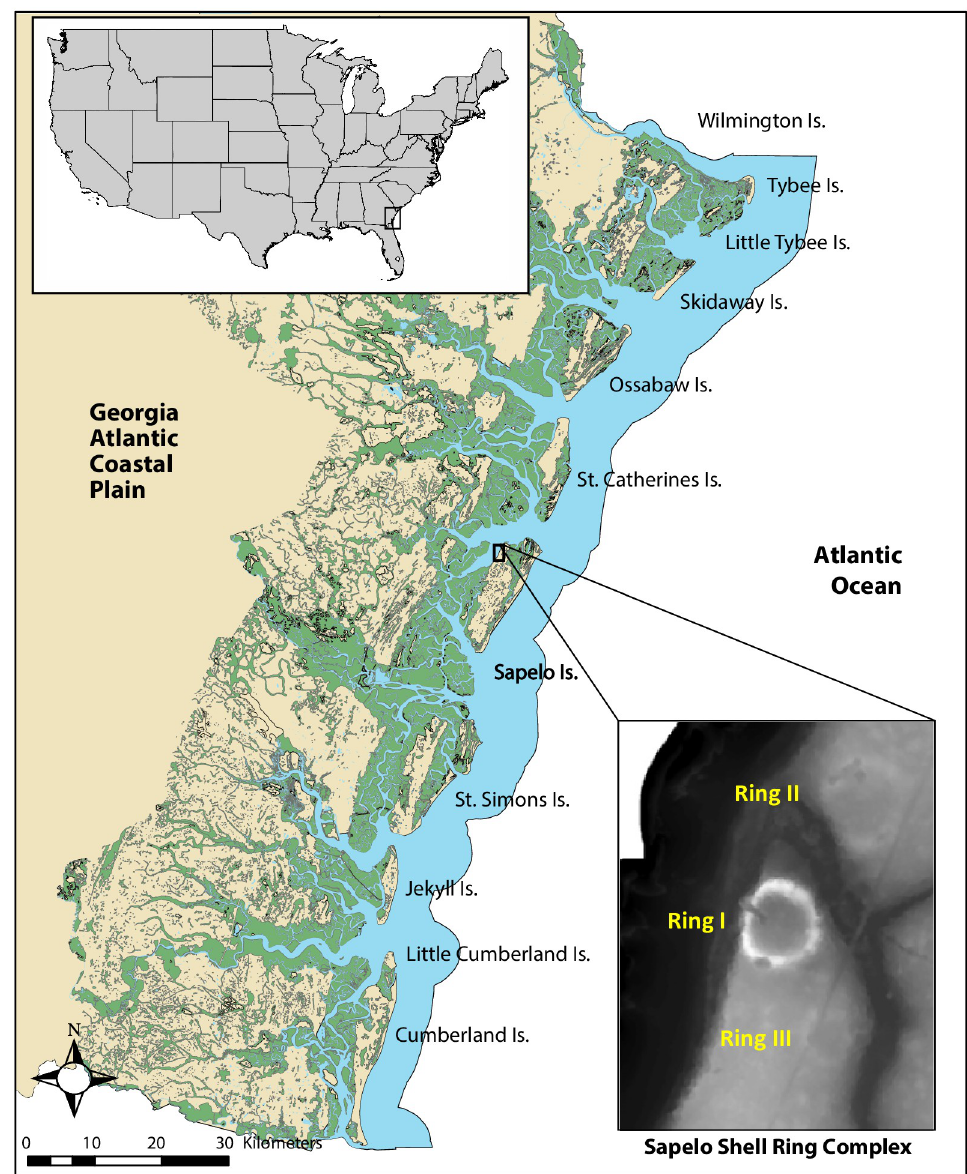
Fig 1. Map of the Georgia coast showing the location of Sapelo Island and shell rings. The map was created by CJG and VDT using ArcGIS Pro and wetland shapefile data from Georgia GIS Clearinghouse (https://data.georgiaspatial.org/